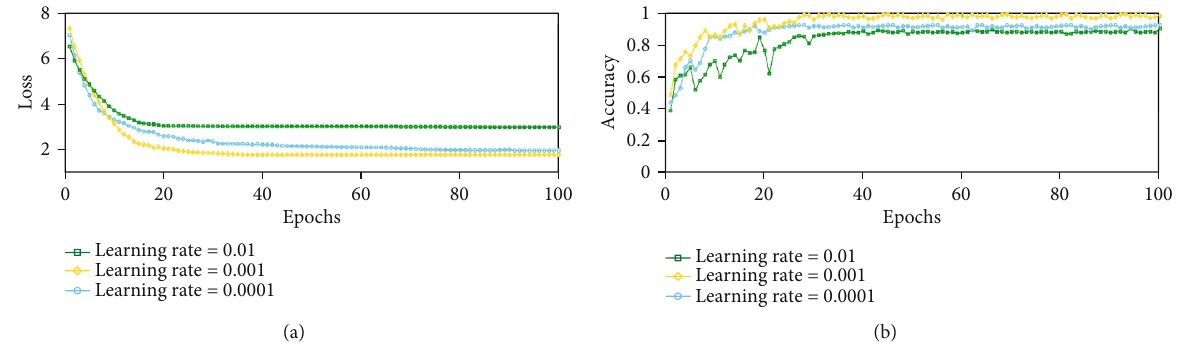
Figure 4: Training and validation curves at di ff erent initial learning rates. (a) Model loss on the training set. (b) Model accuracy on the validation set.